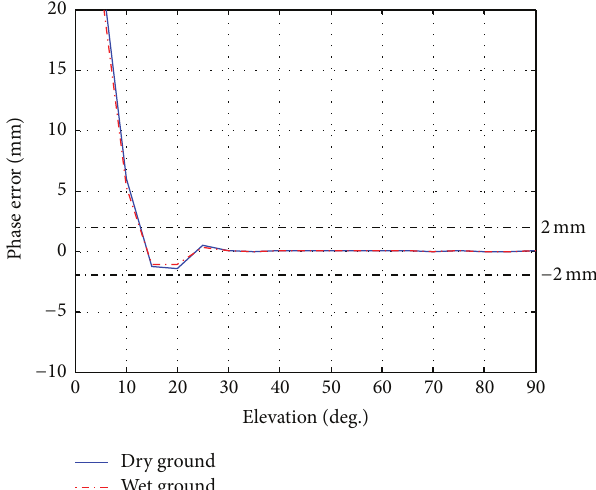
Figure 5: The effect of the multipath on the carrier phase against elevation angle for choke